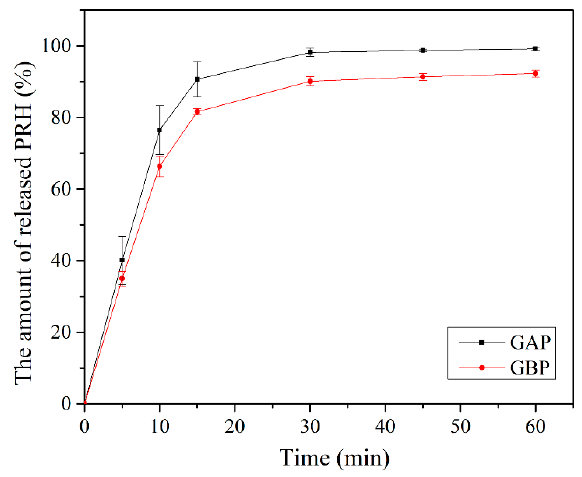
Figure 9. In vitro release study.